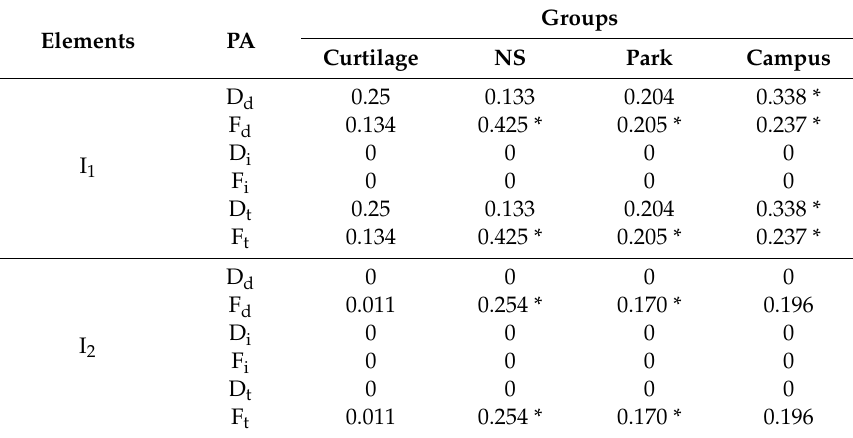
Table A3. The e ff ect of elements on the LPA in the